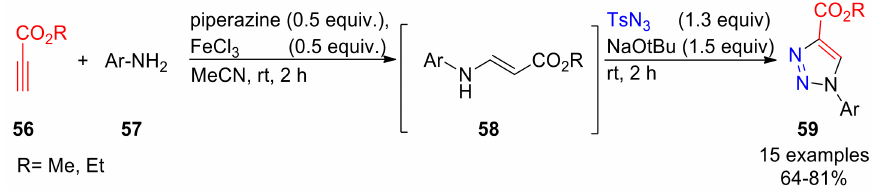
Scheme 19. Metal-free synthesis of 1,4-DTs through enamine